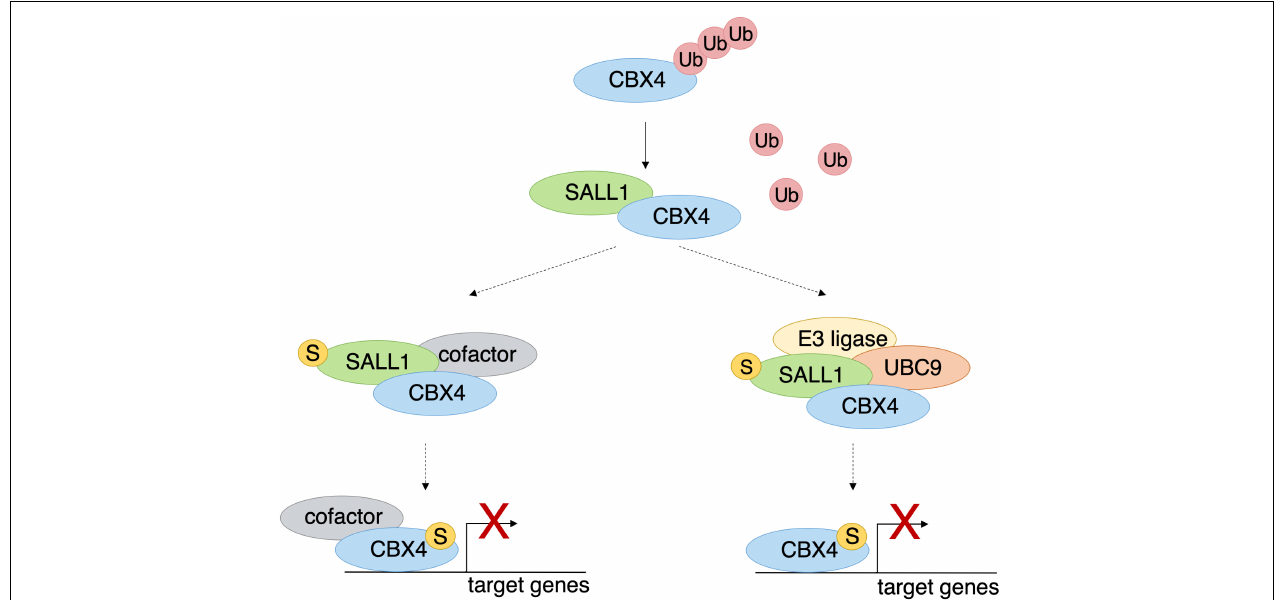
FIGURE 8 | SALL1 influences regulation of CBX4 target genes. Hypothetical model showing speculative scenarios whereby SALL1 could influence CBX4-mediated regulation of target genes. Binding to SALL1 (SUMOylated or non-SUMOylated) could stabilize CBX4 by interfering with its ubiquitination and its consequent degradation by the proteasome. CBX4 stabilization entails an increment of its protein levels and its accumulation in Pc bodies. Binding to SUMOylated SALL1 increases CBX4-mediated transcriptional repression of its target genes. At least two non-exclusive hypothetical mechanisms might underlie this effect. Under one hypothetical scenario (left side), it could be due to the concurrent recruitment of other essential cofactors. In another hypothetical scenario (right side), SUMOylated SALL1 could increase CBX4 transcriptional repression by facilitating its SUMOylation through recruitment of SUMOylation machinery components. Discontinuous arrows indicate speculative events that have not been proven